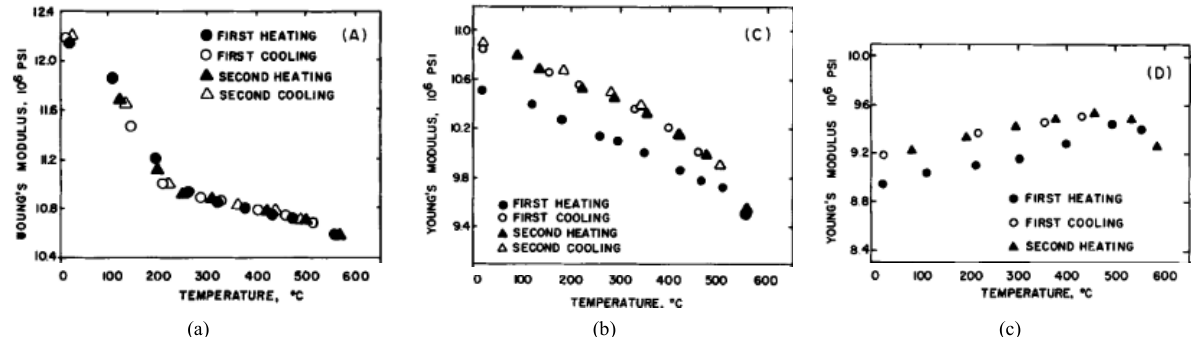
Fig. 2 Temperature dependence of Young’s modulus of (a) CS SLS glass, (b) TT SLS glass and (c) HS BS glass (Kerper et al. 1966).